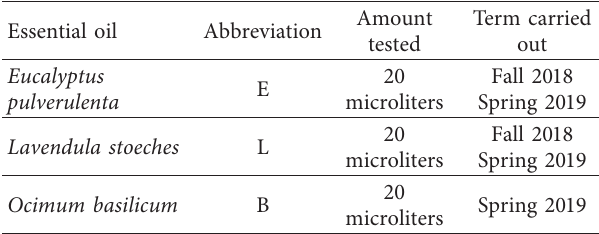
Table 2: Summary of antimicrobial essential oil